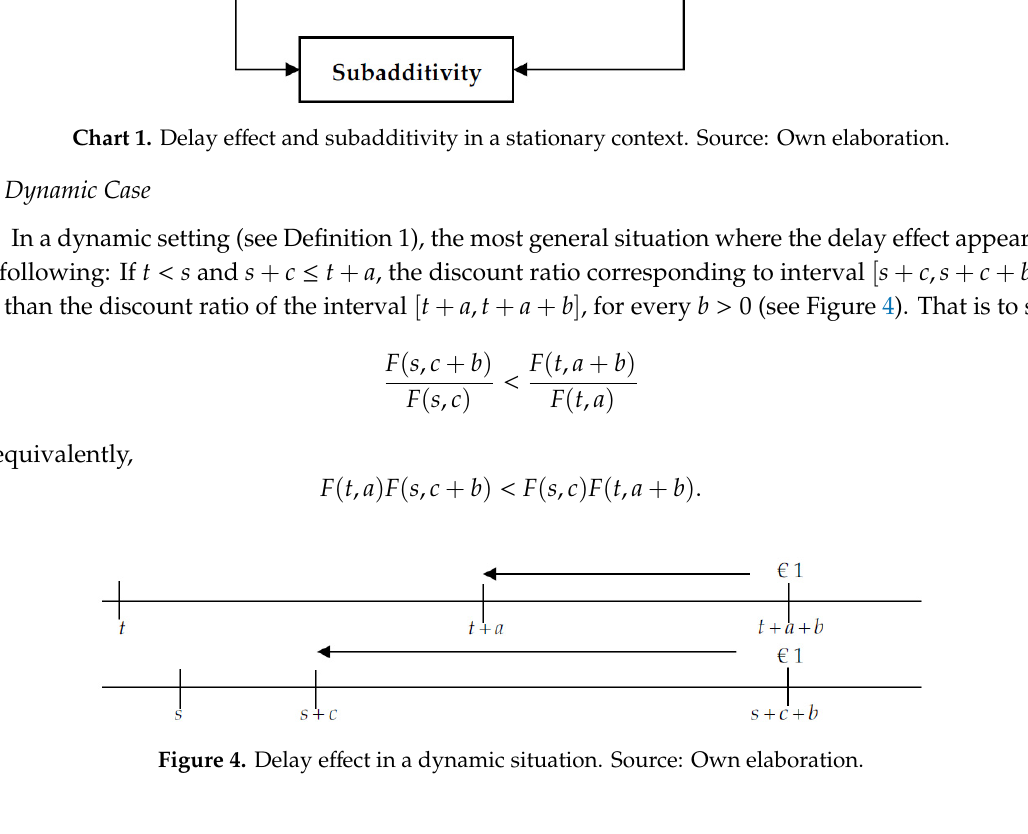
Figure 4. Delay effect in a dynamic situation. Source: Own elaboration.